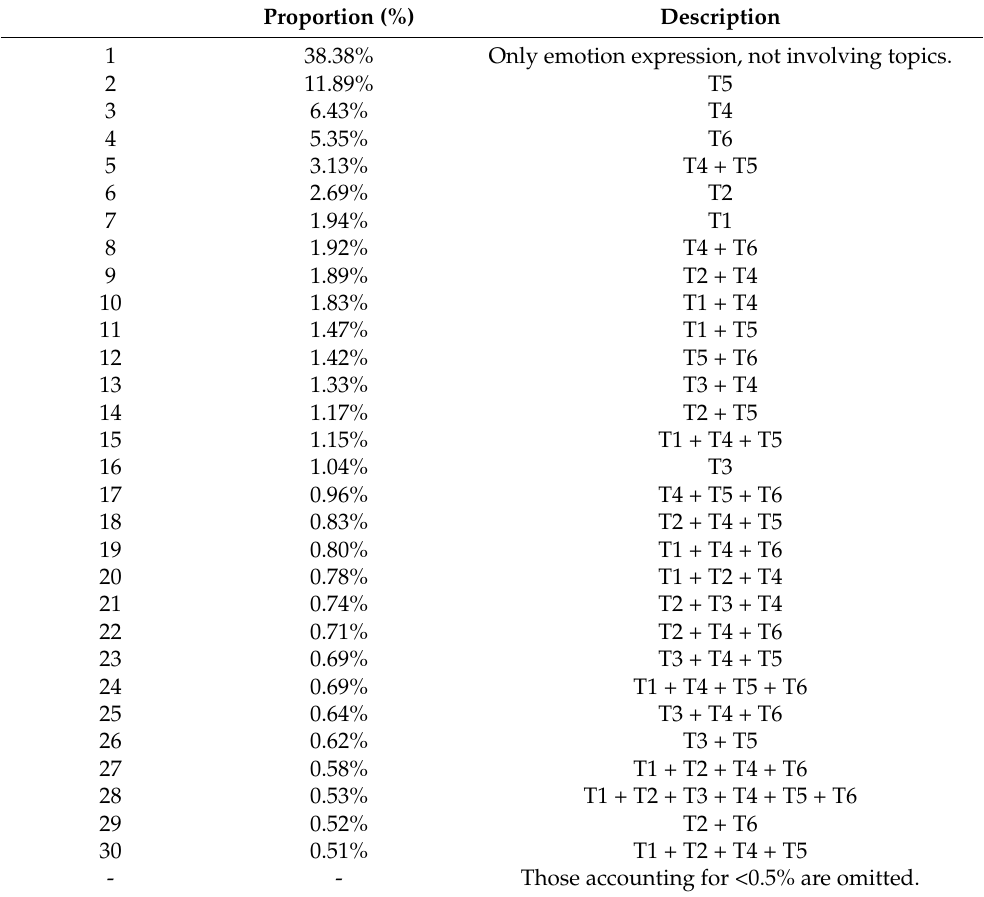
Table 3. Semantic identified results of multi-label classification model. Proportion (%) Description 1 38.38% Only emotion expression, not involving topics. 12 of 20